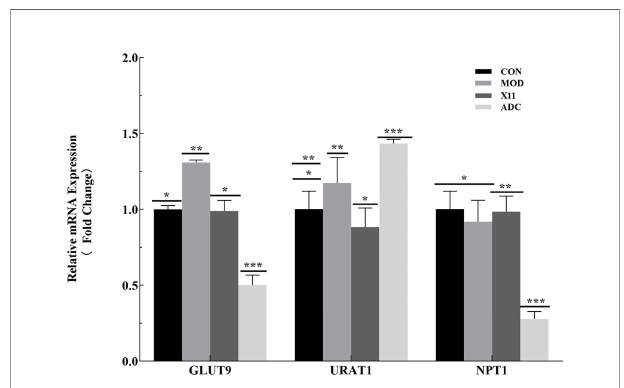
FIGURE 6 | Effects of Lactobacillus paracasei X11 on transporter expression level of mice. The same number of asterisks indicates no signi fi cant difference and the different number of asterisks indicates signi fi cant difference. (P <